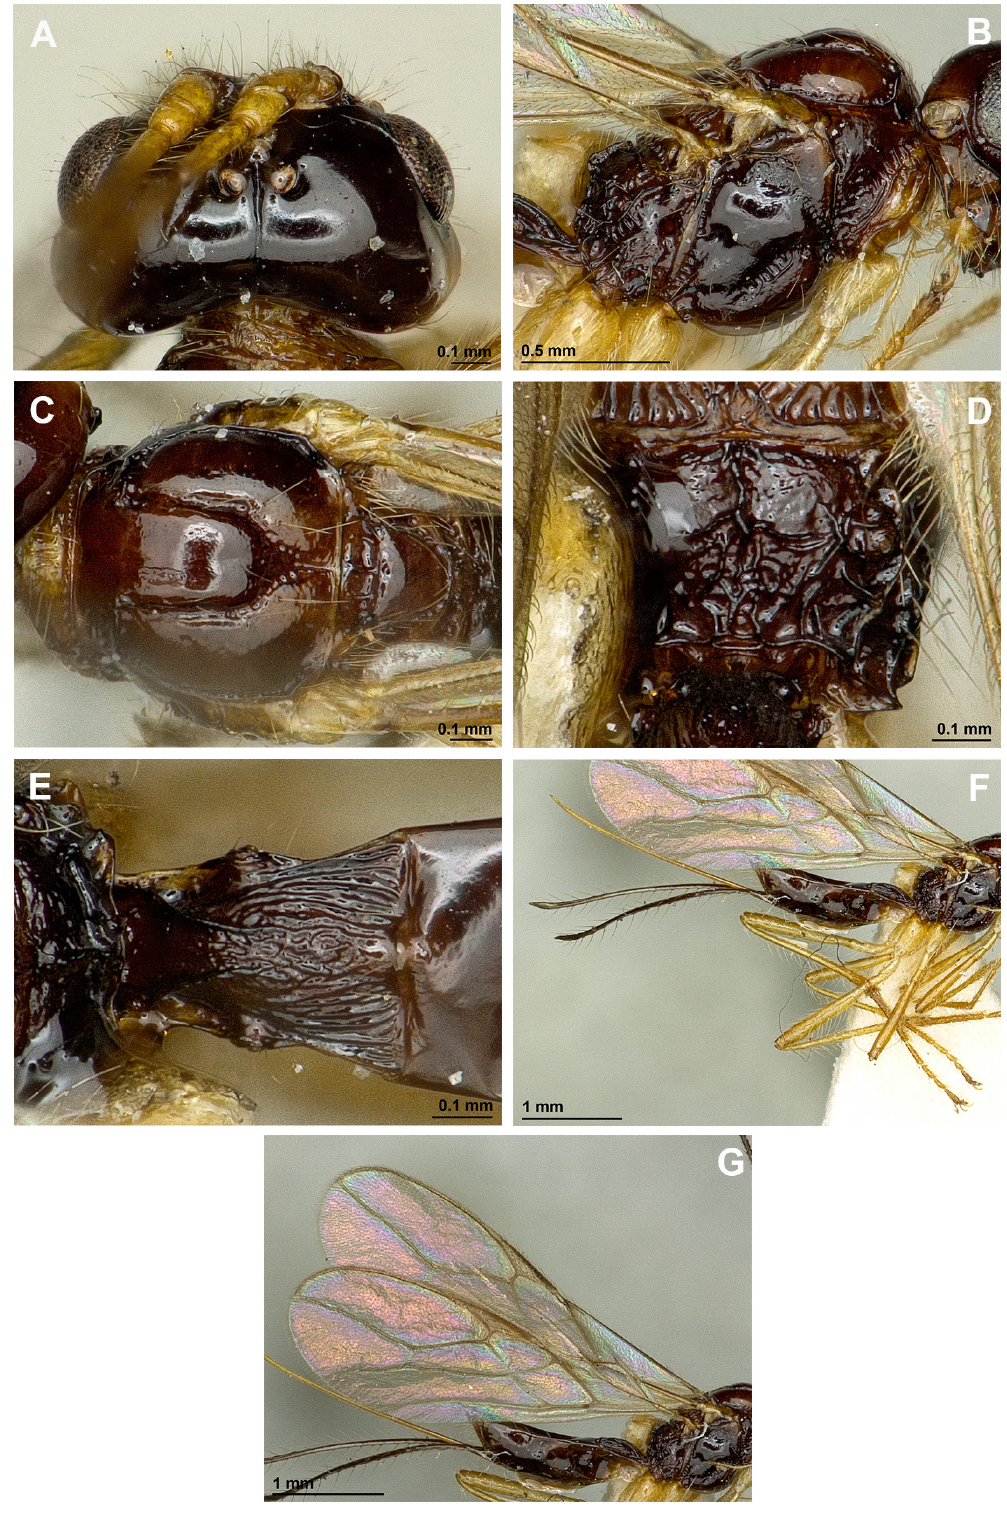
Fig. 67. Asobara turneri Peris-Felipo, 2014, ♀, holotype (BMNH). A . Head, dorsal view. B . Mesosoma, lateral view. C . Mesoscutum, dorsal view. D . Propodeum, dorsal view. E . First metasomal tergite, dorsal view. F . Hind leg, metasoma and ovipositor, lateral view. G . Fore and hind